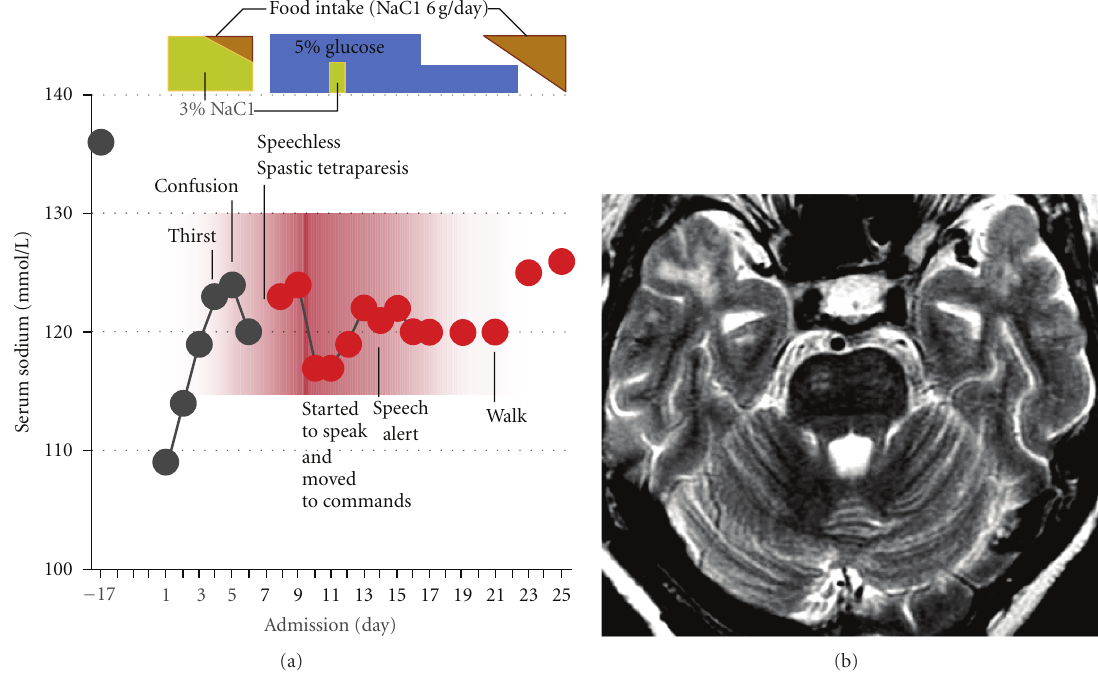
Figure 1: (a) Schematic presentation of the clinical course of the patient. (b) Axial, T2-weighted MR image of the pons. Three linear hyperintense lesions are observed in the center of the